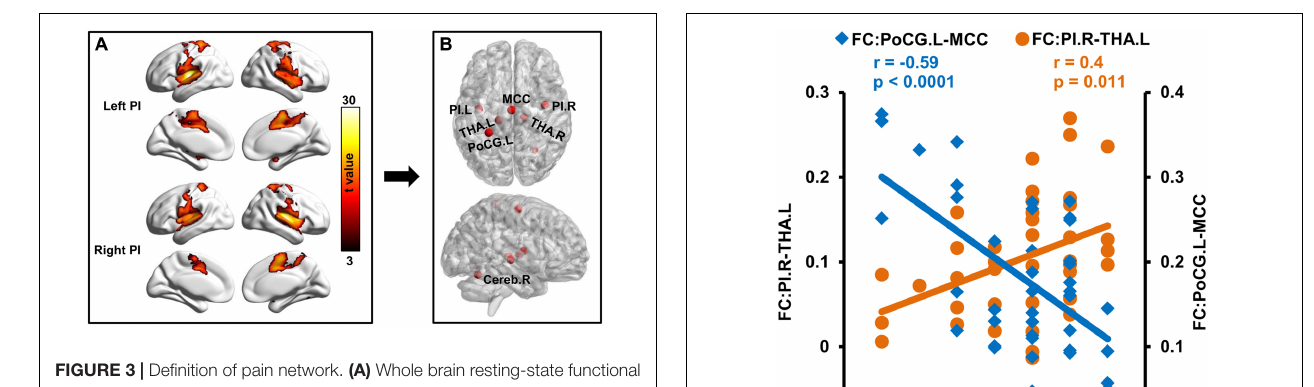
FIGURE 3 | Definition of pain network. (A) Whole brain resting-state functional connectivity analyses of the bilateral posterior insula (PI) were performed and corrected using family wise error (FWE) correction method with p < 0.05 to identify the brain regions functionally connected to bilateral PIs. (B) Several brain areas including bilateral PI, bilateral thalamus (THA.L, THA.R), middle cingulate cortex (MCC), left postcentral gyrus (PoCG.L), and right cerebellum (Cereb.R) were identified and defined as pain network. TABLE 2 | The MNI peak coordinates of the pain network related brain regions, obtained with whole brain functional connectivity analyses of the bilateral posterior insula in healthy controls.